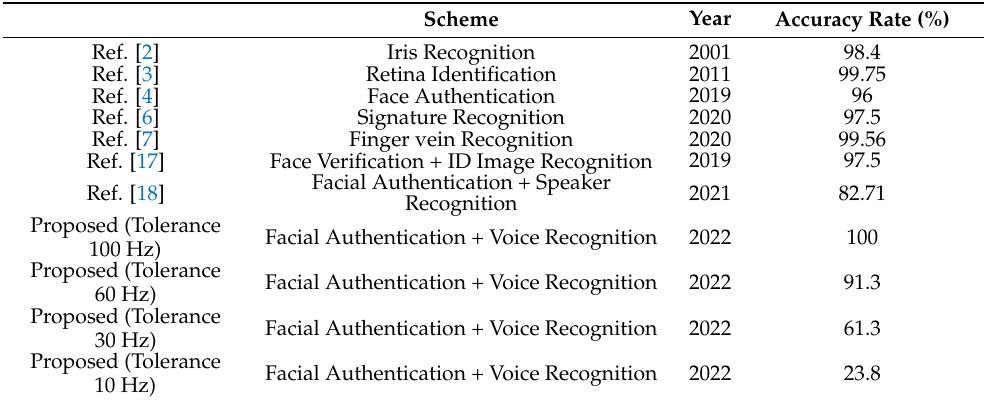
Table 1. Comparison of recognition results.